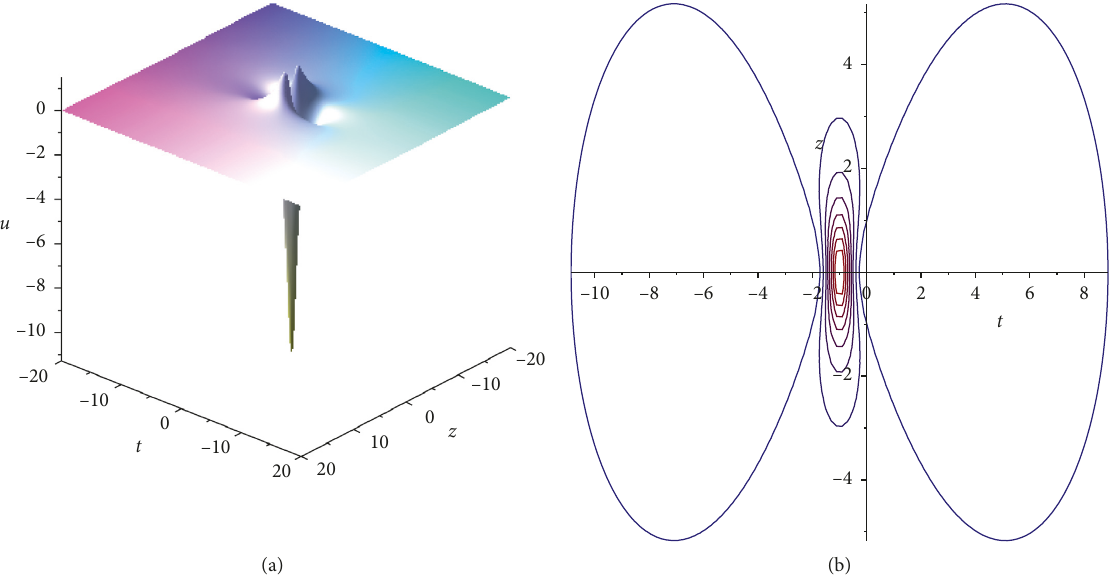
Figure 1: Structure of the lump solution (12) with x � y � 0: (a) the three-dimensional plot; (b) the density plot.